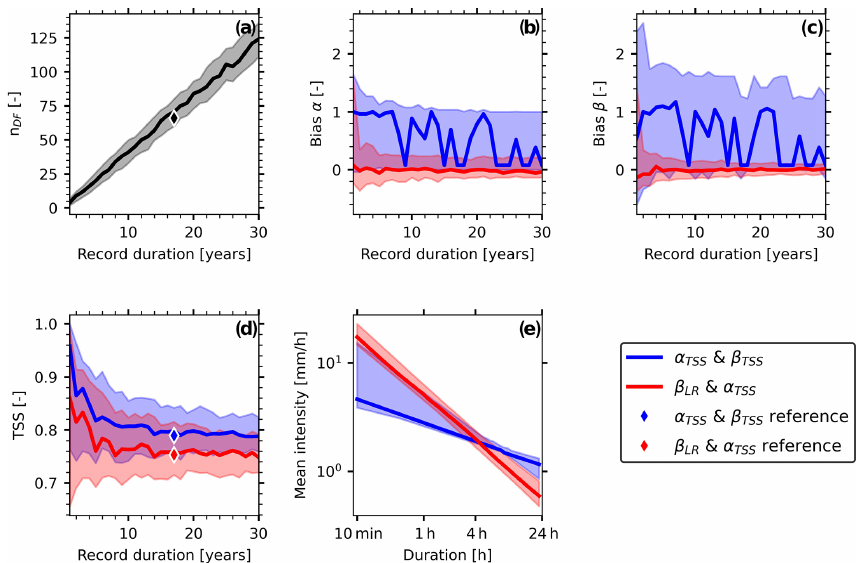
Figure 5. ID-threshold sensitivity for the Illgraben catchment, assessed by resampling (bootstrapping) 100 times for each record duration (1–30 years) from the 17-year data set of debris-flow-triggering and non-triggering rainfall events. (a) Number of debris flows; (b) bias in the scale parameter α ; (c) bias in the shape parameter β ; (d) true skill statistic (TSS); (e) ID thresholds with variability from the observed record duration of 17 years. Solid lines are the medians, and shaded areas comprise the 10th to 90th percentiles of the resampled data. The diamonds (reference) refer to the values obtained when the full 17-year data set is